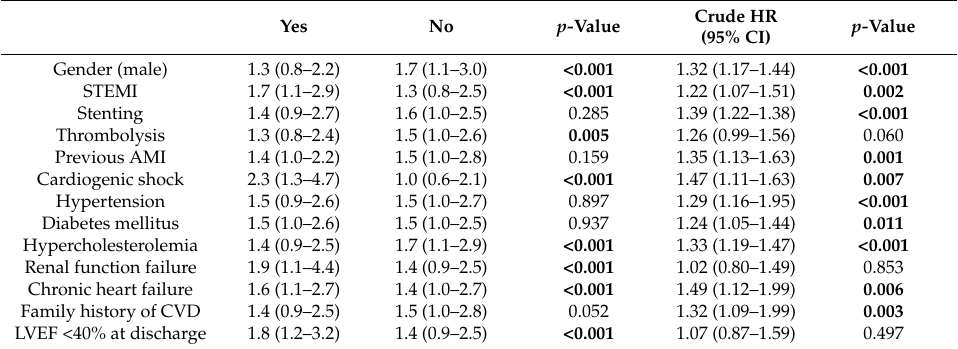
Table 2. Median De–Ritis values and its impact on mortality within categorical